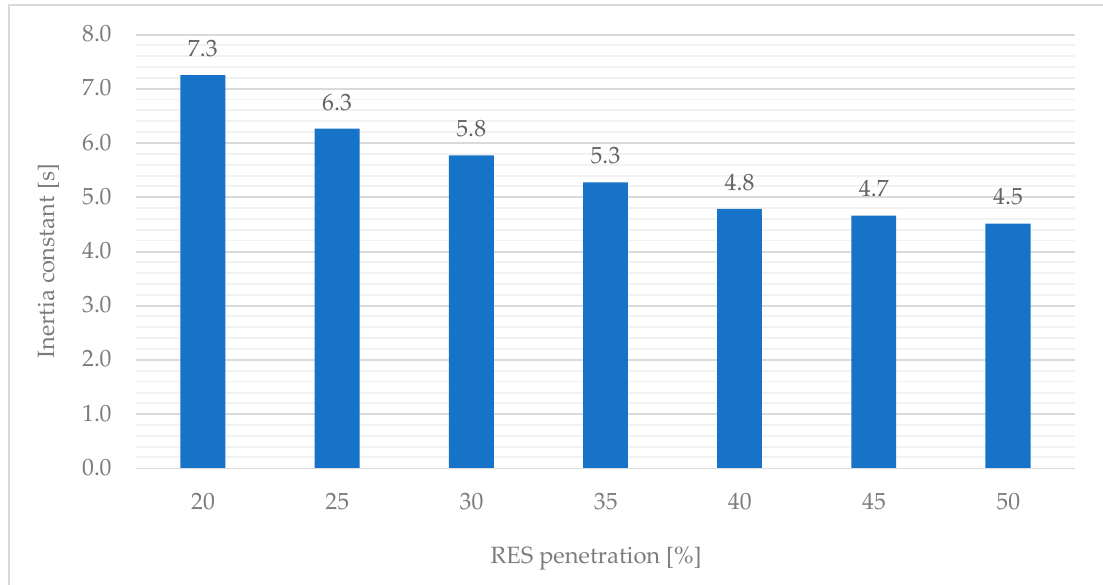
Figure 8. Inertia constant interdependency with RES share.